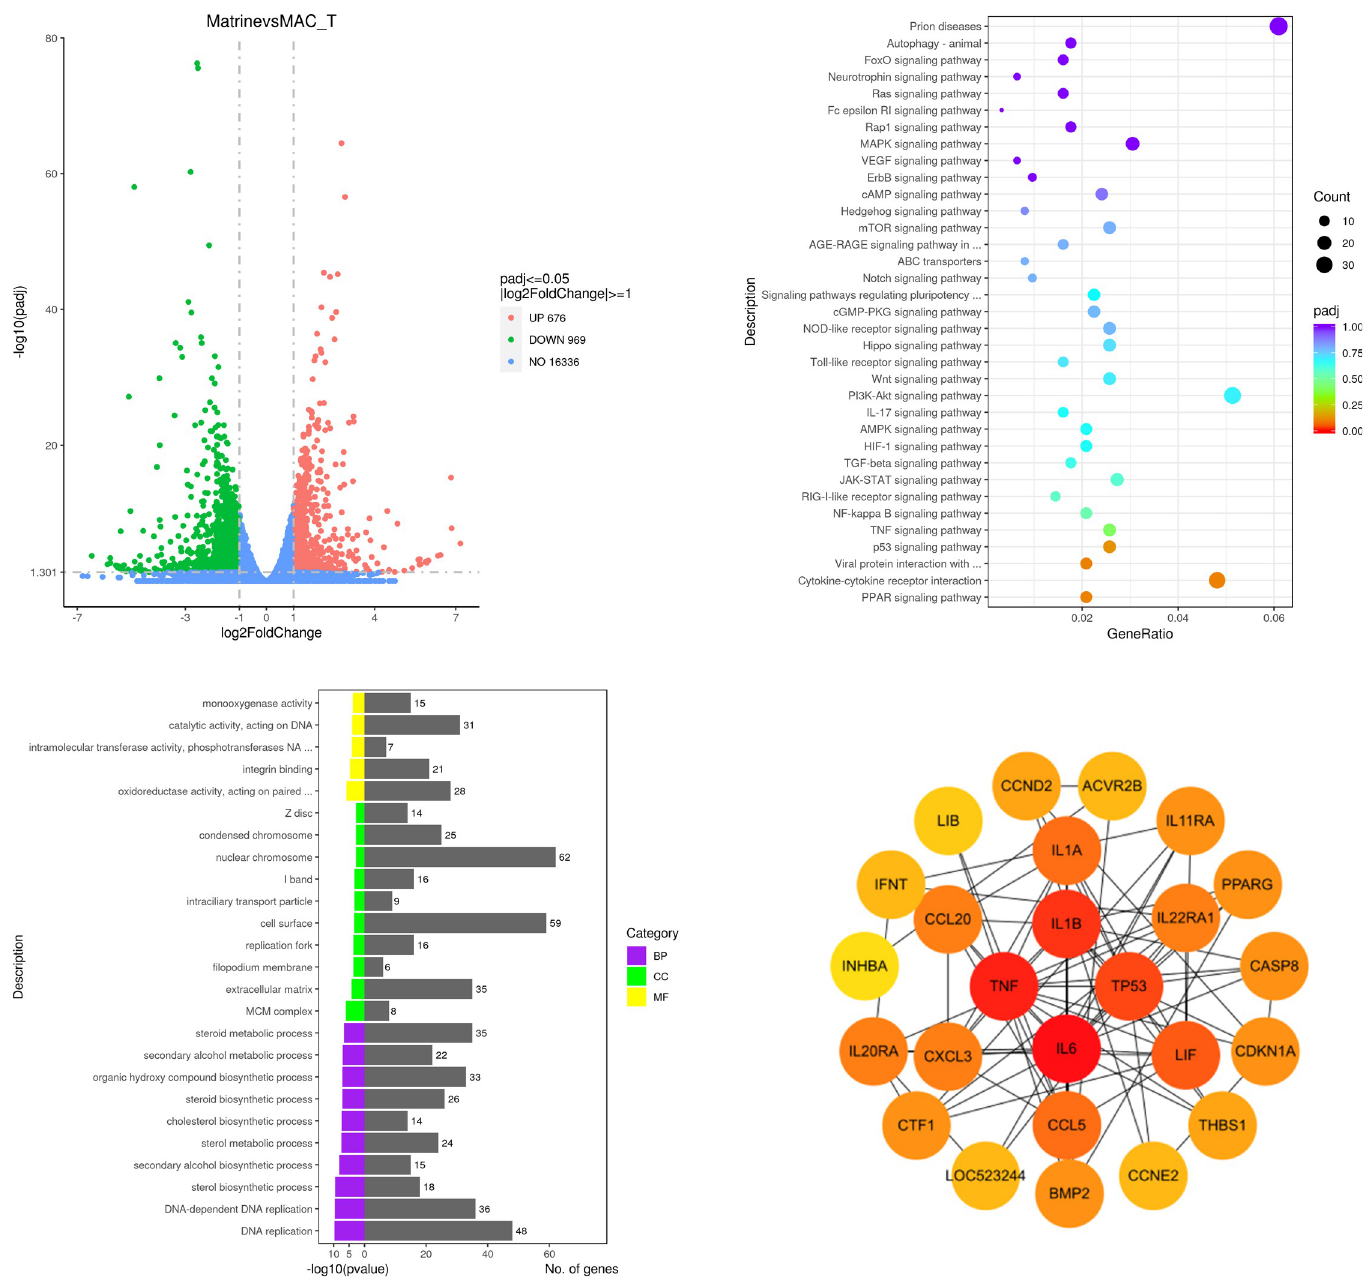
Fig 2. Transcriptome data analysis. A.Volcano plot of total differentially expressed genes in matrine-treated MAC-T cells. Log2|Fold Change| > 1 and p < = 0.05 are thresholds. Red plots represent up-regulated DEGs and green plots represent down-regulated DEGs. B. GO functional enrichment pathway of matrine-treated groups. C. KEGG enrichment analysis of selected DEGs in matrine-treated groups. D. The protein − protein interaction (PPI) networks of selected DEGs.